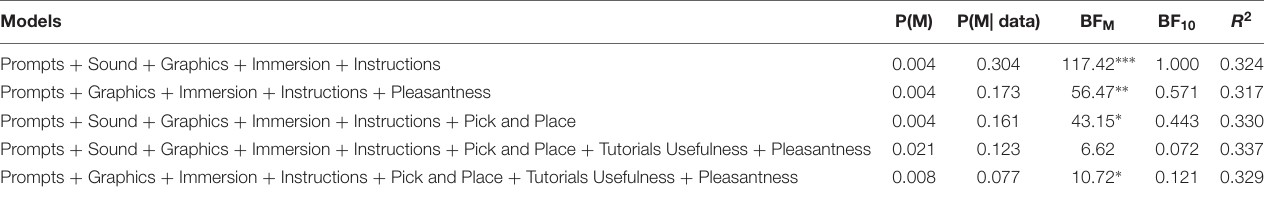
TABLE 8 | Models’ comparison: predictors of VRISE score. Models